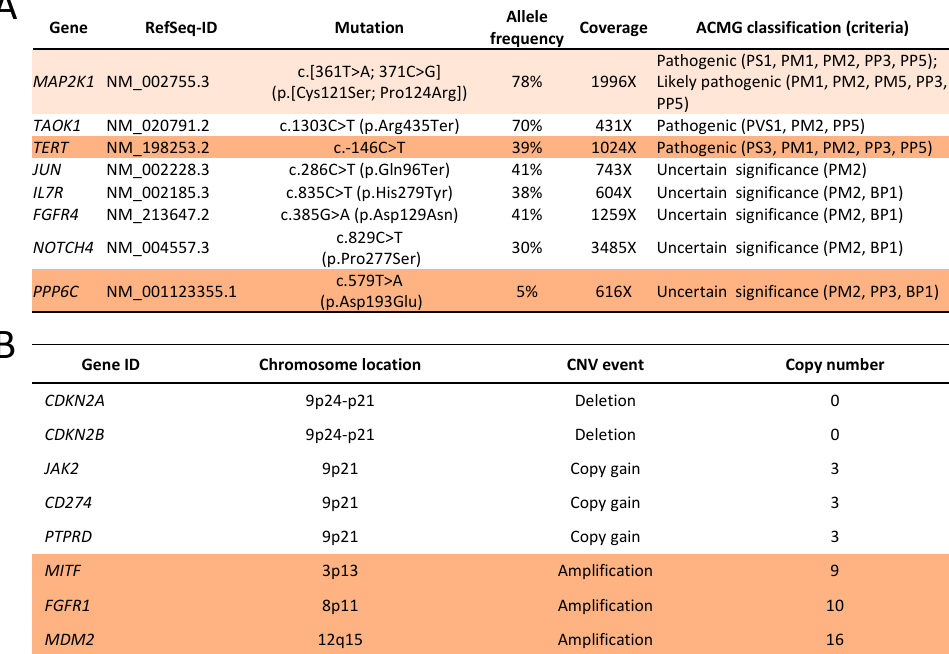
Figure 4. ( A ) List of mutations detected by next-generation sequencing in a tumour biopsy after failure of MEK inhibition alone; ( B ) Selection of copy number variations detected by next-generation sequencing in a tumour biopsy after failure of MEK inhibition alone.